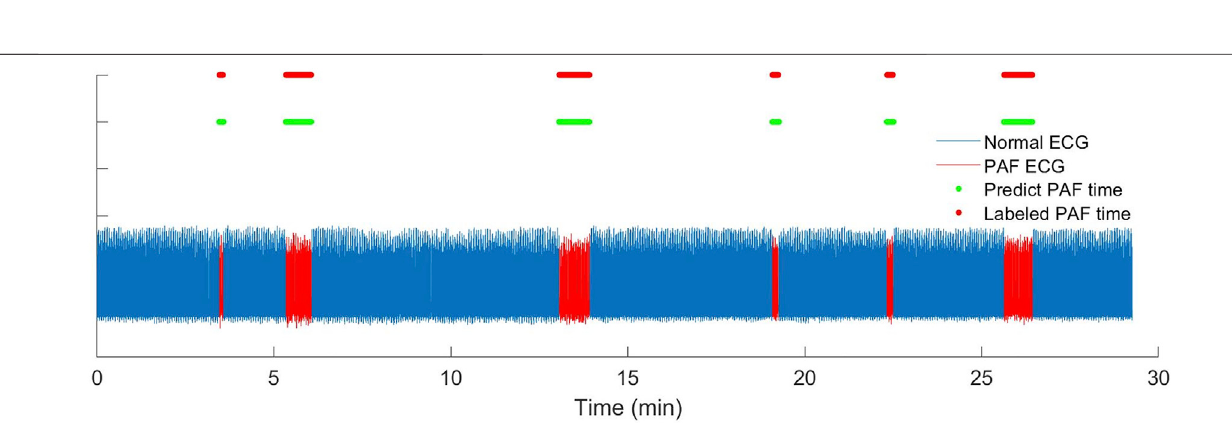
Frontiers in Physiology |